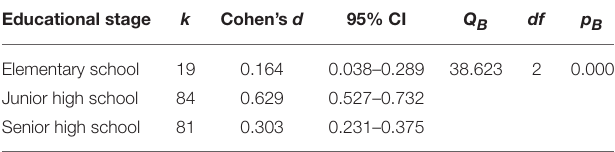
TABLE 5 | Mean effect sizes grouped according to educational